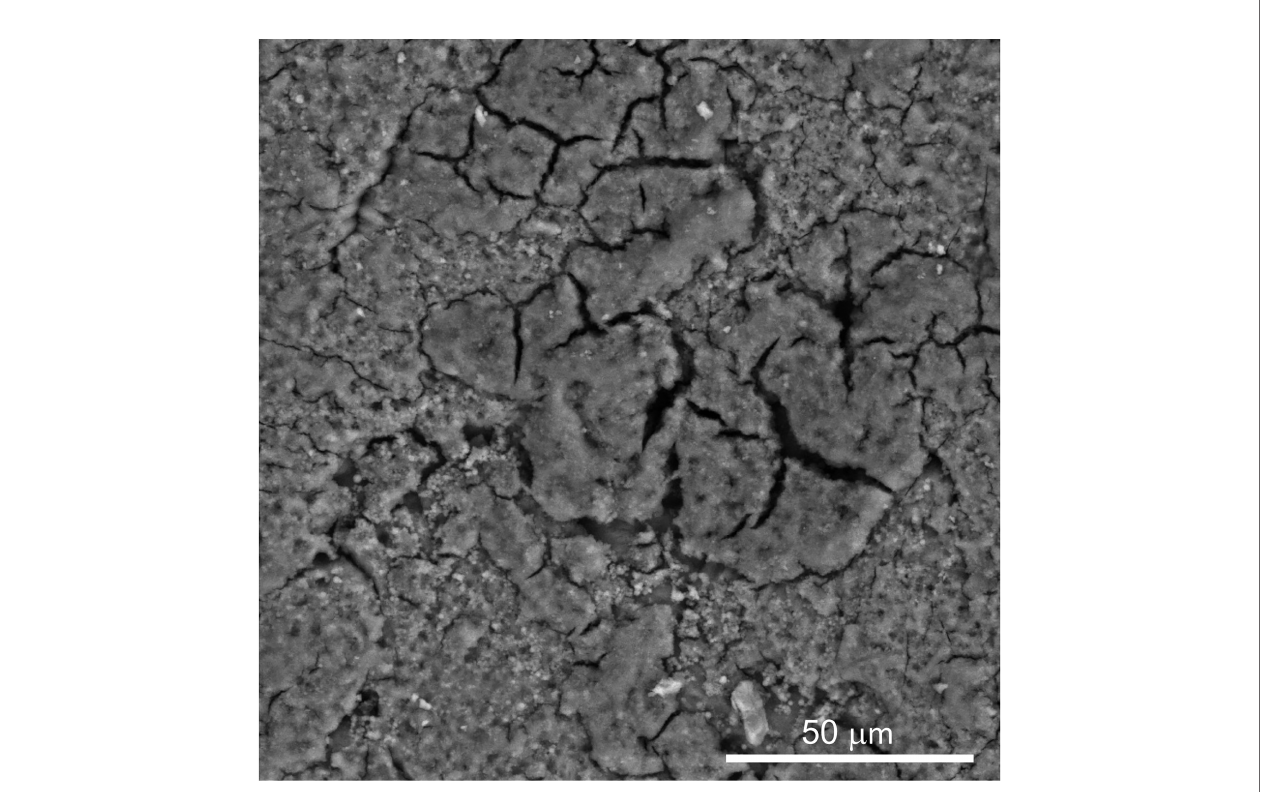
FIGURE 5 | Scanning electron micrograph (SEM) image of outer surface of chicken eggshell cuticle at 1000X showing patchy distribution with cracks and fi ssures. (Original fi gure by GK).